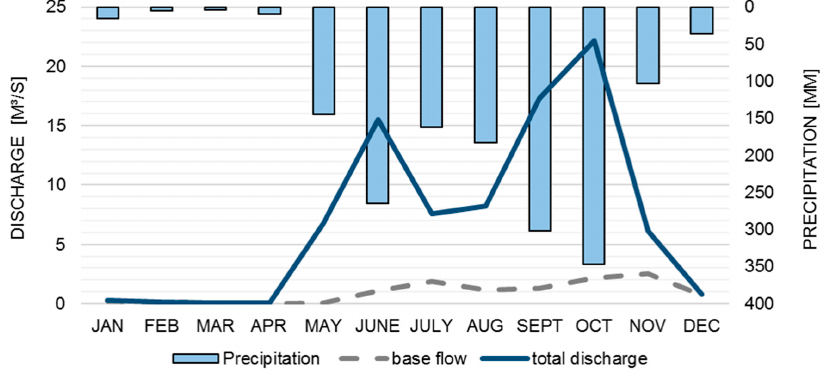
Figure 8. Long-term average monthly precipitation ( P mean ; WorldClim), base flow ( Q b ), and total discharge ( Q tot ) of Brito and Las Lajas catchments.